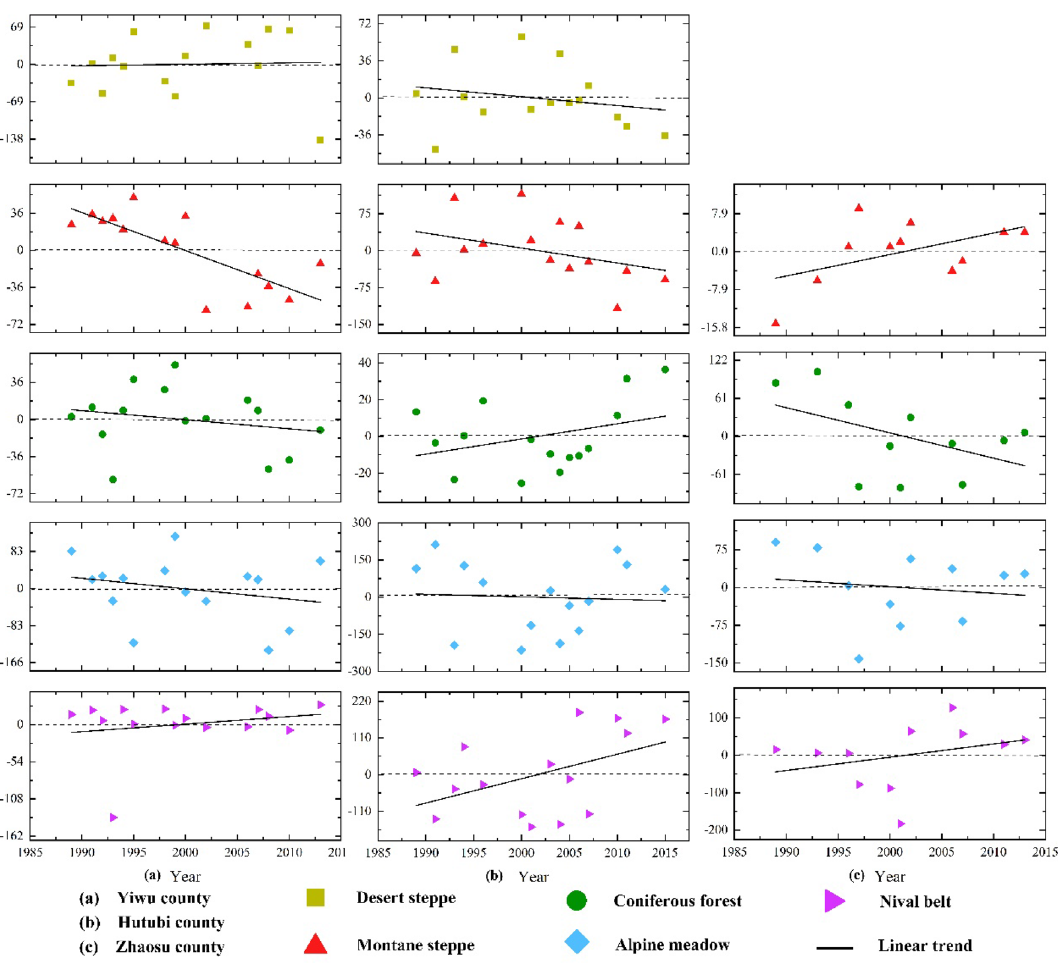
show the trend of the lower limit of the nival